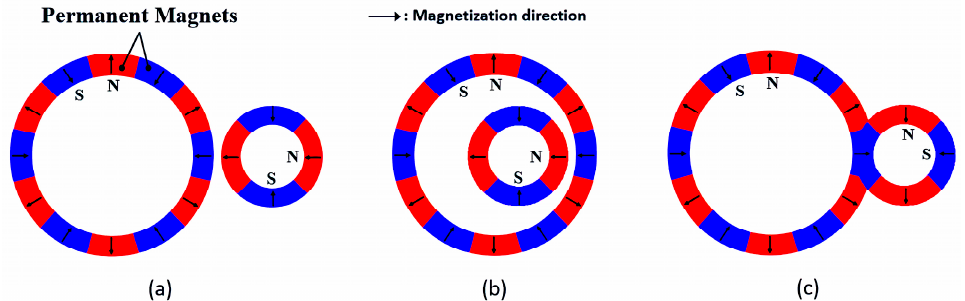
Figure 3. Parallel-axis magnetic spur gears: ( a ) External radial coupling; ( b ) Internal radial coupling; ( c ) Axial coupling.